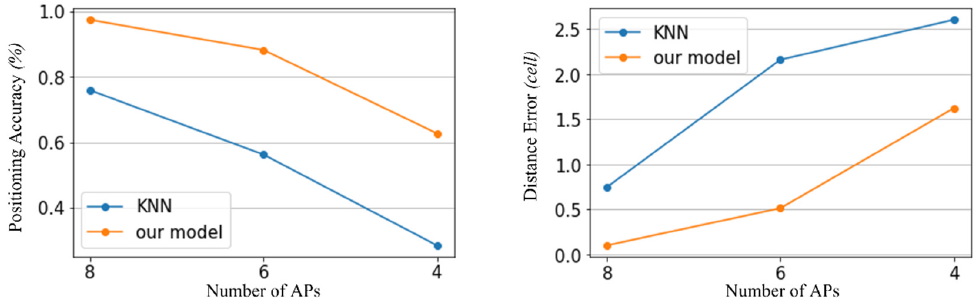
Figure 14. Comparison results between the proposed scheme and the algorithm-based fingerprint- ing method (KNN). method